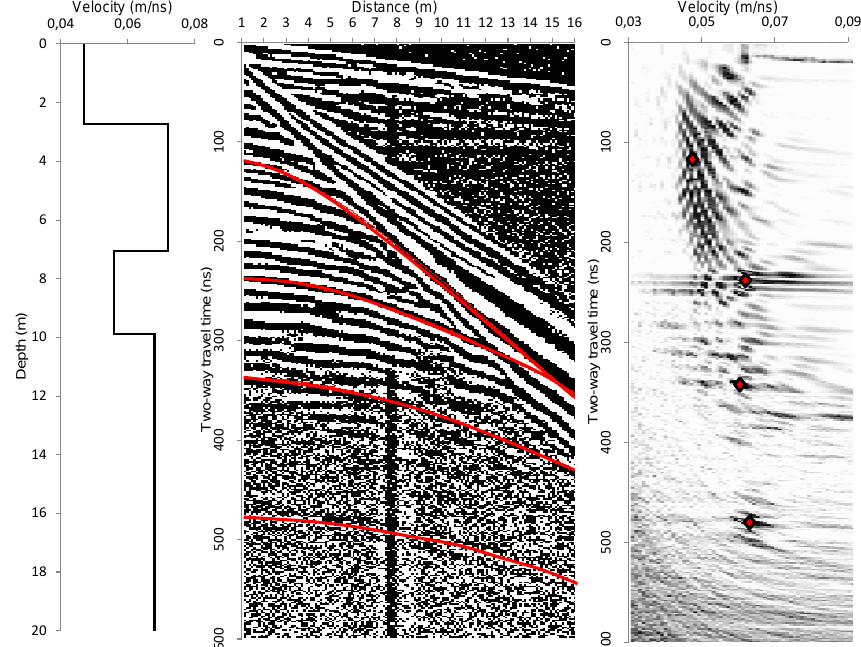
Figure 3. Estimated velocity profile, recorded CMP radargram, and semblance plot for the CMP transect measured on the drained lake surface. The semblance plot shows more likely velocities in darker shades of grey with the velocities from the reflectors (red lines in radargram) used for generating the velocity profile indicated by black and red